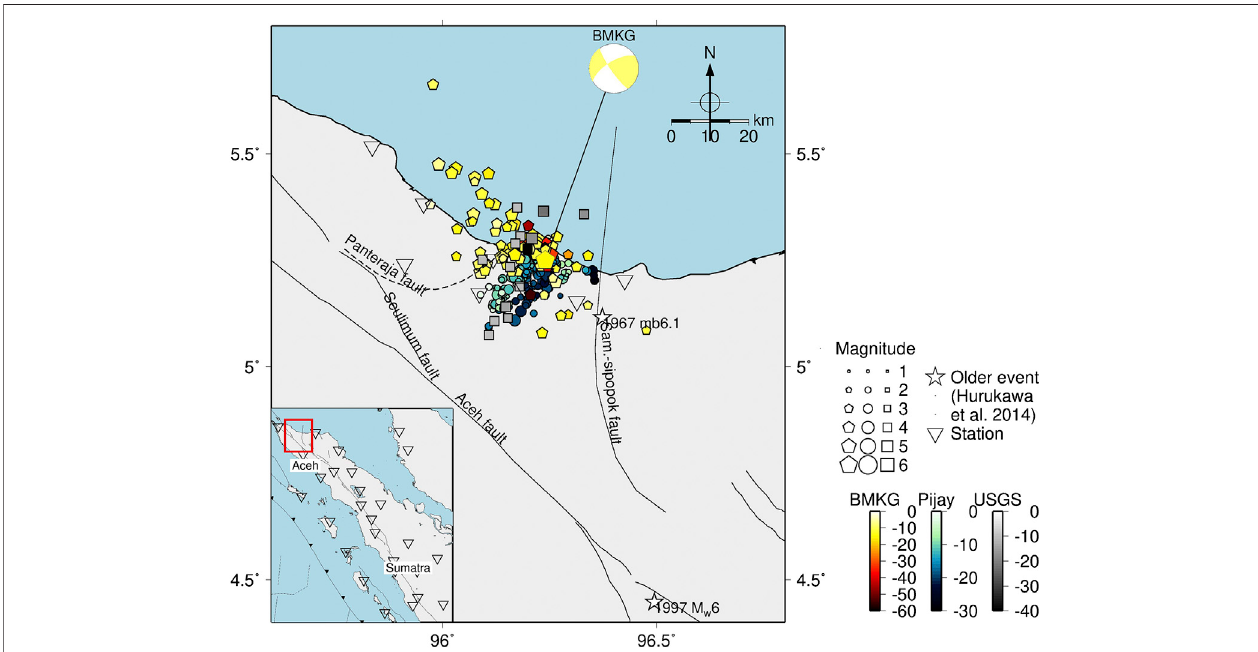
FIGURE 1 | Mainshock and aftershocks (BMKG, Pijay, and USGS network) of the Pidie Jaya 2016 earthquake. Focal mechanism (mainshock) is from BMKG. The relocated BMKG aftershocks (December 7 – 19, 2016) from Supendi et al. (2017) are plotted with a yellow pentagon. Relocated Pijay aftershocks (December 14, 2016 – January 15, 2017) from Muzli et al. (2018) are plotted with blue circle. USGS aftershocks (December 6 – 17, 2016) are plotted with a gray square. The relocated Pijay network aftershocks are creating planar fault that dips 63 ° toward southeast (Muzli et al., 2018); white stars are relocated past events from Hurukawa et al. (2014). Samalanga-Sipopok Fault is taken from Barber et al. (2005). Panteraja Fault is taken from Muzli et al. (2018). Seulimum and Aceh Faults are taken from the National Center for Earthquake Studies of Indonesia (PUSGEN). The fi gure was modi fi ed from Kusumawati et al. (2019b) and Sahara et al.